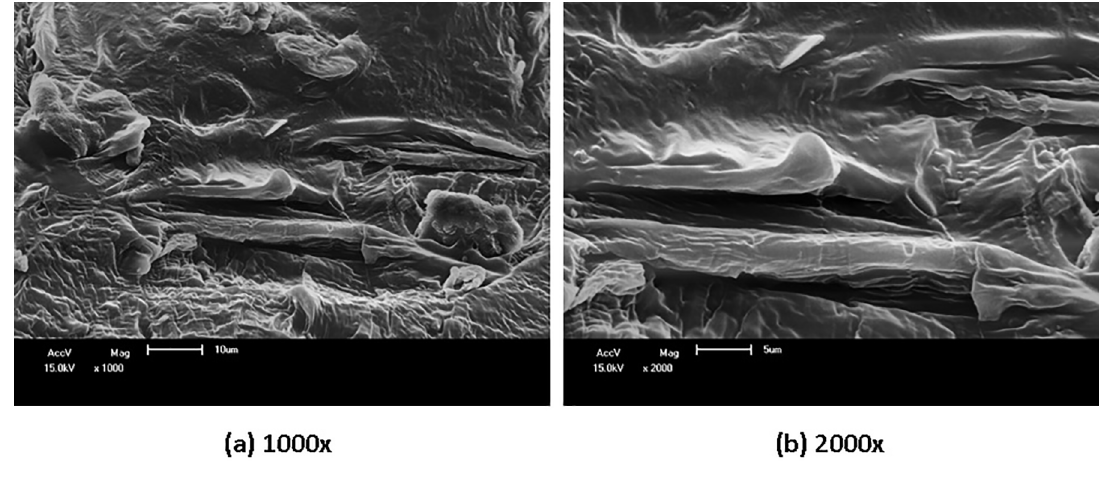
Figure 9. SEM images of PCL/MMT in different magnifications, on the Figure 9a with magnification of 1000x and the Figure 9b with magnification of 2000x.